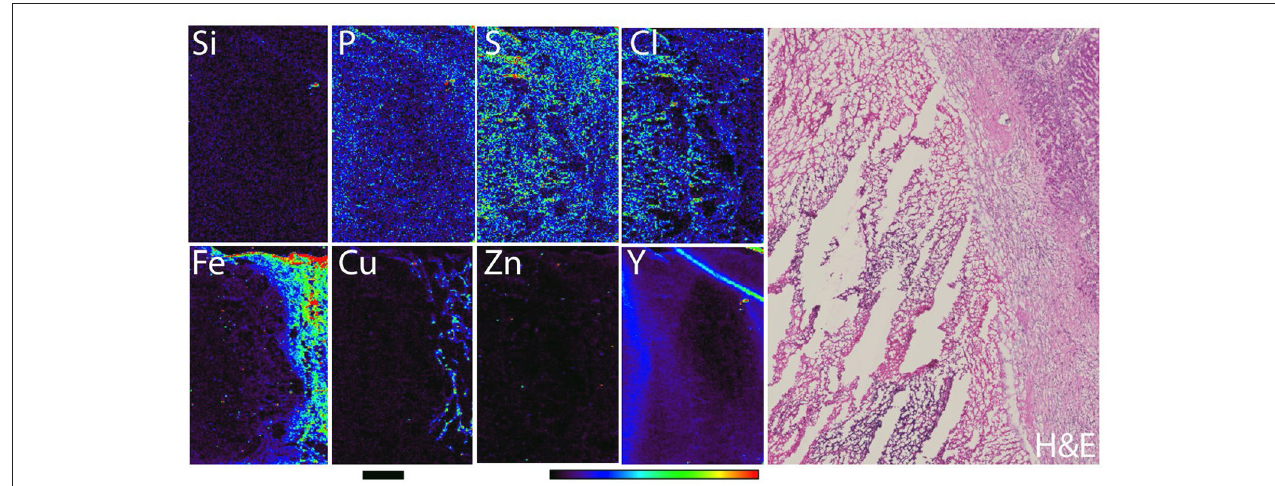
FIGURE 4 | Rabbit liver with VX2 tumor necrotic region (left half of the sample) and VX2 viable part of the tumor (right-hand side of the sample). Elemental map was obtained with 30 micron spot size scanning, at X-ray energy 15 keV (station 8BM-B). Scale bar − 2mm, color bar indicates elemental quantity as represented by false colors, from black (no signal) to red (highest signal). Hematoxylin and eosin staining of the same region in one of the adjacent tissue sections is shown in the right hand